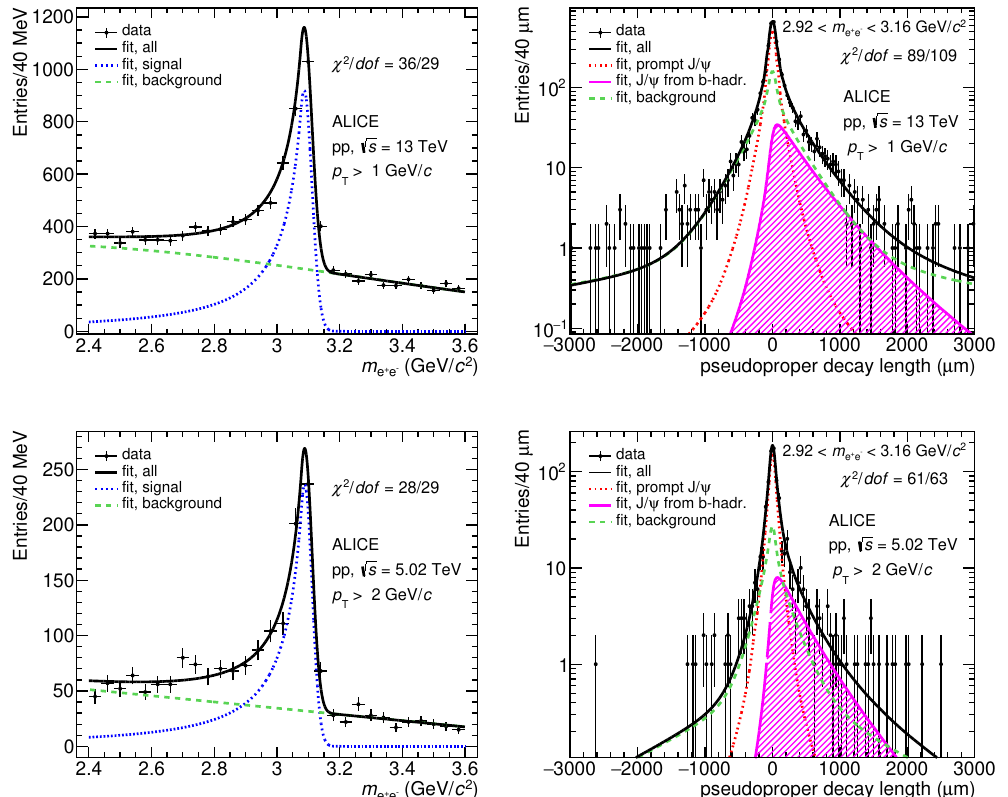
Figure 1 . Invariant mass (left panels) and pseudoproper decay length (right panels) distributions for J /ψ candidates at midrapidity with superimposed projections of the maximum likelihood fit. Pseudoproper decay length distributions are shown for J /ψ candidates reconstructed under the J /ψ mass peak, i.e. for 2 . 92 < m ee < 3 . 16 GeV/ c 2 , for display purposes only. The distributions refer to the p T -integrated case, in particular the upper (lower) panels show the distributions for p T > √ 1 (2) GeV/ c in pp collisions at s = 13 (5.02) TeV. The χ 2 values, which are computed considering the binned distributions of data points and the corresponding projections of the total fit function, are also